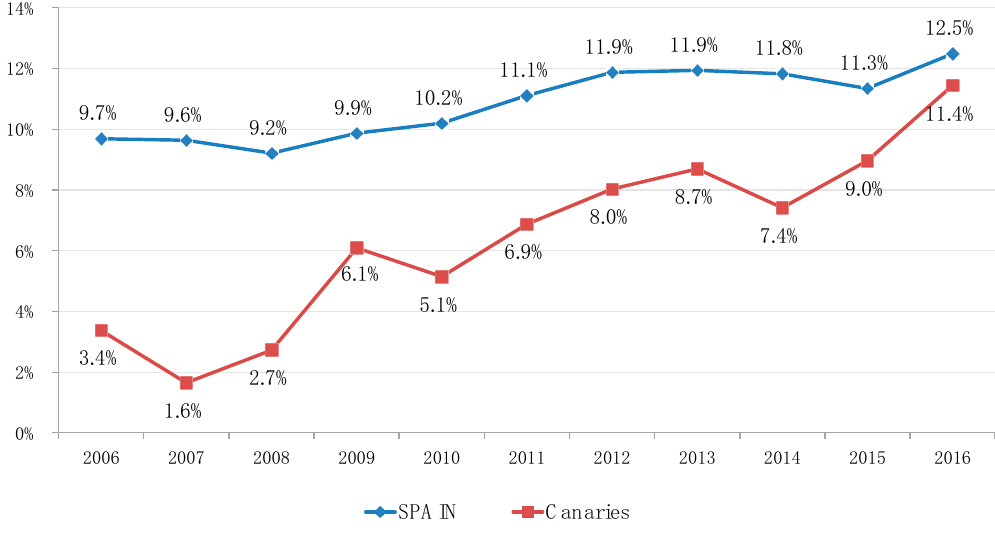
Figure 5. Trend of CEPI in Spain and the Canary Islands.